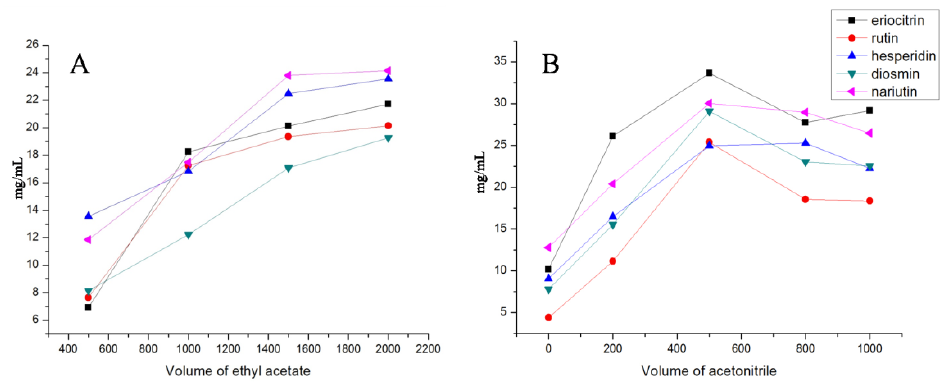
Figure 2. The evaluation of extraction conditions of the amount of ethyl acetate ( A ) and acetonitrile ( B ).